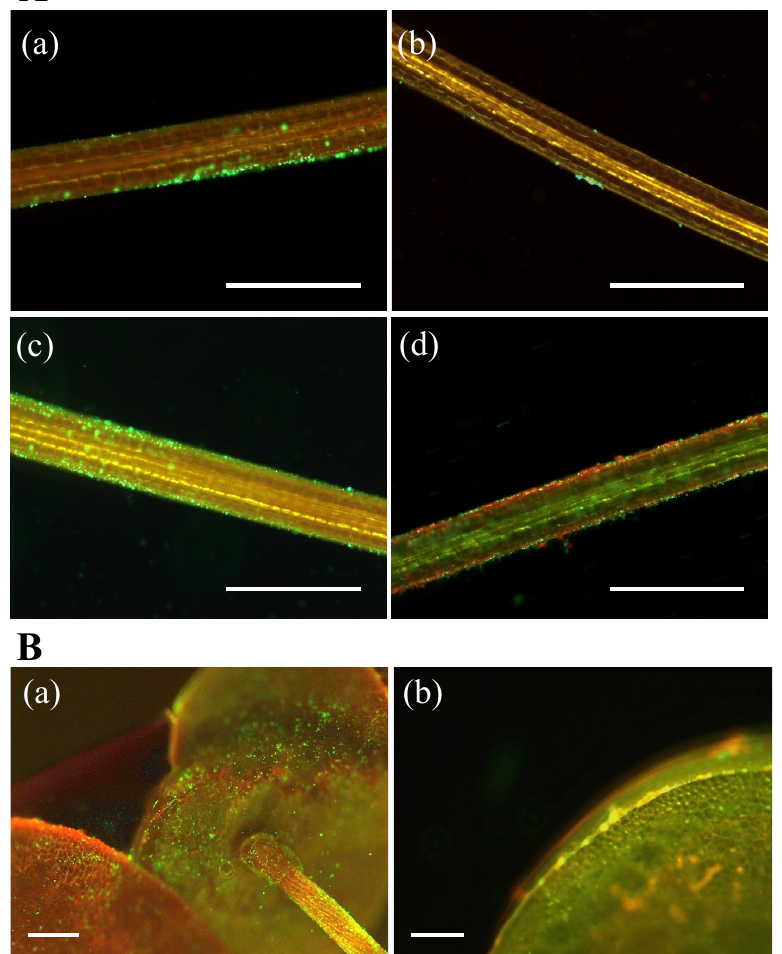
Figure 4. Fluorescent micrographs of LIVE/DEAD-stained bacterial cells attached on roots and fronds of Lemna minor co-cultured with the PGPB strains MRB1–4. ( A ): Micrographs show the duckweed roots harboring strains ( a ) MRB1 at day 14, ( b ) MRB2 at day 3, ( c ) MRB3 at day 14, and ( d ) MRB4 at day 3. Scale bars, 200 µm. ( B ): Micrographs exhibit the duckweed harboring MRB3 ( a ) on the frond ventral side of the root at day 3 and ( b ) on the frond dorsal side at day 14. Scale bars, 250 µm. All cells shown here were stained green using SYTO9 for viable cells or red using propidium iodide for dead cells.